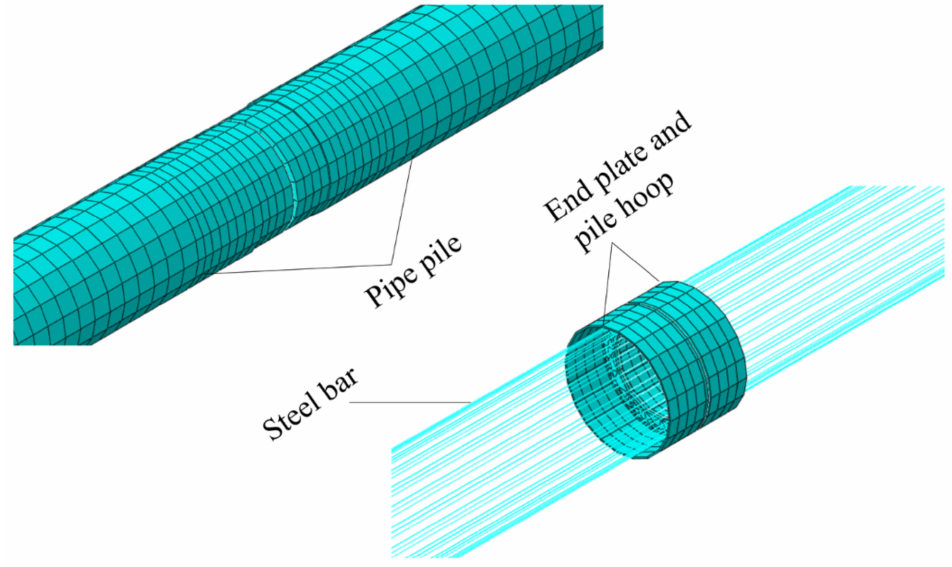
Figure 4. Schematic diagram of finite element